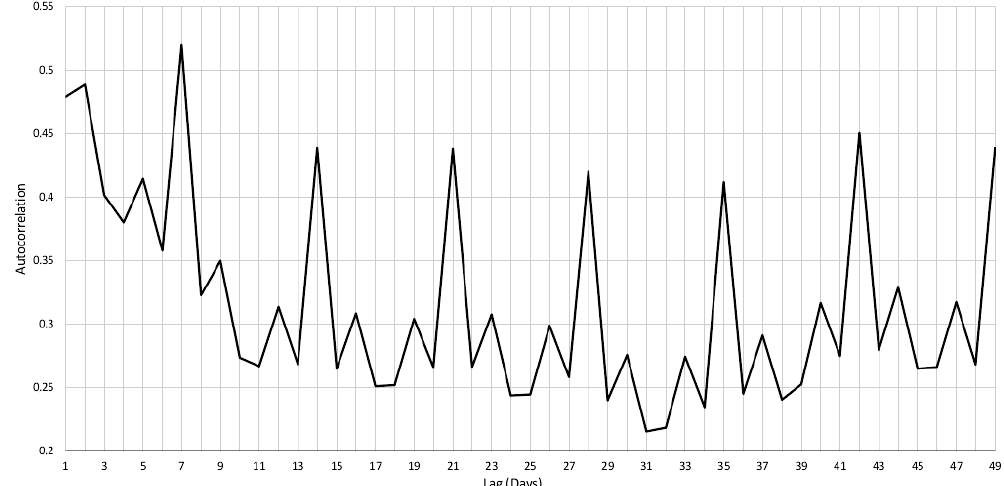
Figure 1. Average autocorrelation values of all road segments during period